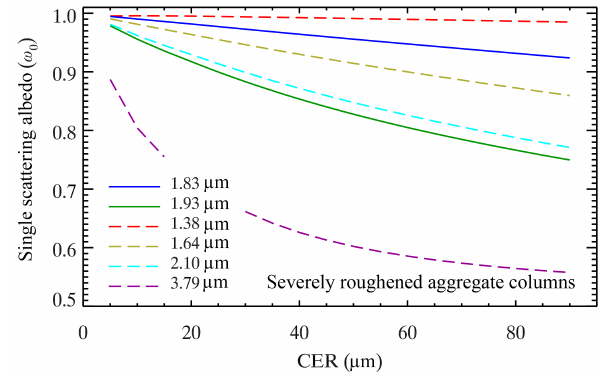
Figure 2. Bulk single scatter albedo ( ω 0 ) for severely roughened aggregate hexagonal column ice crystals as a function of cloud ef- fective particle radius (CER) for the eMAS 1.83 and 1.93µm chan- nels (blue and green, respectively) and the MODIS 1.38, 1.64, 2.1, and 3.79µm channels (dotted red, gold, light blue, and magenta,